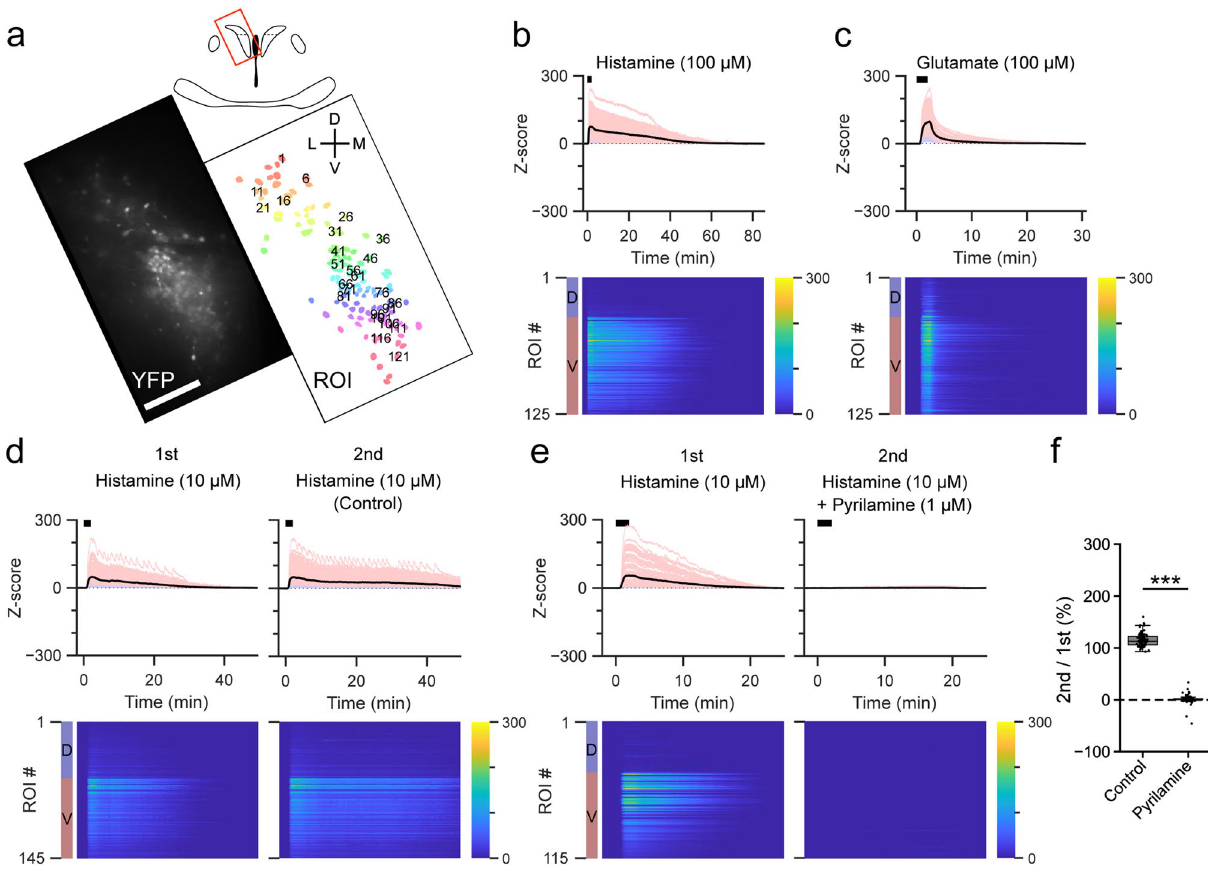
Figure 4. Effect of histamine on PVN-CRF neurons. ( a ) YFP signal (left) and regions of interest (ROIs, right) of a representative brain slice. The brain region is indicated by the red box in the upper illustration. Numbers superimposed over the ROIs align with the dorsoventral axis (from dorsal to ventral). D dorsal, V ventral, L lateral, M medial; scale bar: 100 μm. ( b – e ) Z-scores of the YFP/CFP ratio recorded from each representative brain slice, ( b ) and ( c ) are from the brain slice shown in ( a ). Upper graphs show traces of individual ROIs (light blue: dorsal PVN, light red: ventral PVN) and mean value (black). Black bars indicate the application timing (2 min) of each substance, histamine (HA) in ( b ), ( d ) and ( e ), glutamate in ( c ). Heat maps show the Z-scores of individual ROIs indicated by the color bars at right. Blue and red color bars at left indicate the dorsal (D) and ventral (V) portions of the PVN. HA was applied twice in ( d ) and ( e ). The histamine H1 receptor-selective antagonist pyrilamine was applied 10 min before the second application of HA in ( e ). (f) Box plots of ratio of the area under the curve of the Z-scores of the ventral PVN between the first and second application of histamine with and without antagonist. Dots show individual data. ***p < 0.001, Mann–Whitney U